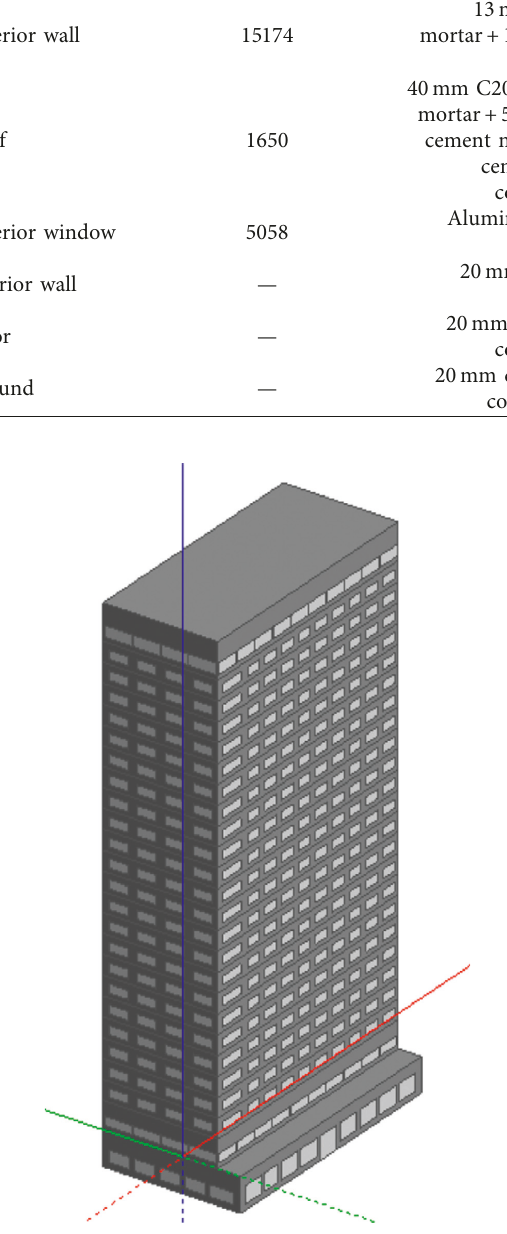
Figure 4: Establishment of the benchmark building